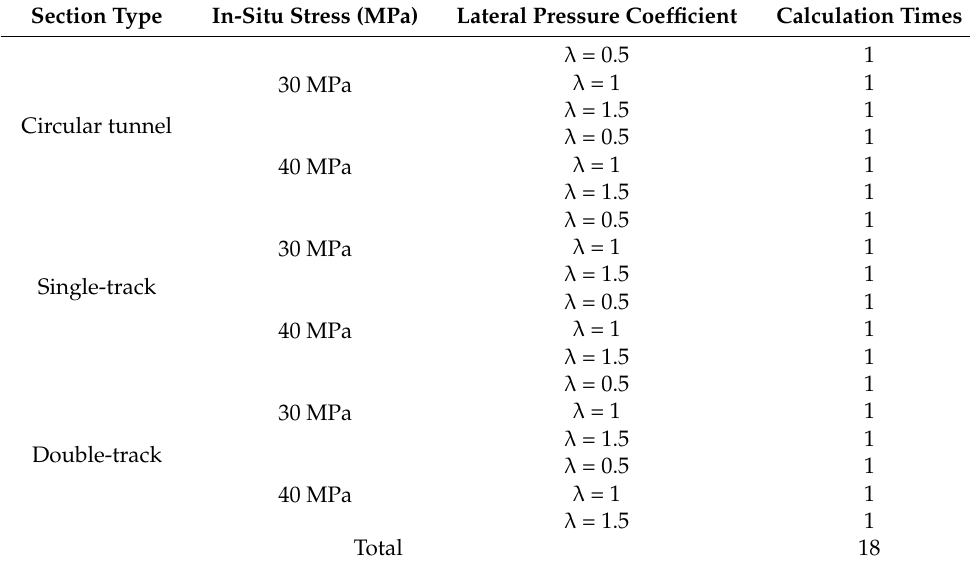
Table 5. Calculation condition table.